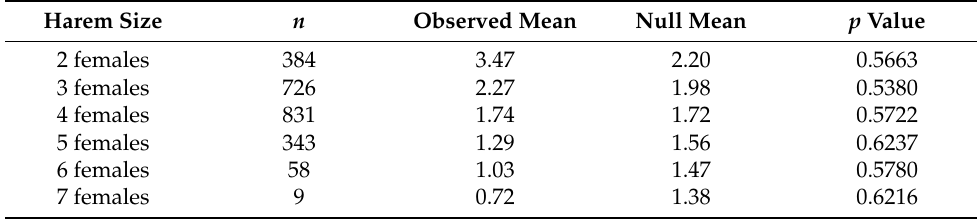
Table 4. Summary table of the observed and null mean minimum distance (cm) between two females within a harem, for each harem size of 2 to 7 females per male across all treatments. Harem Size